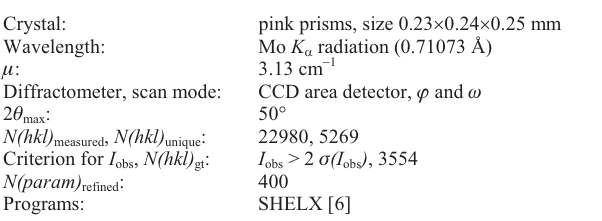
Table 1. Data collection and handling.